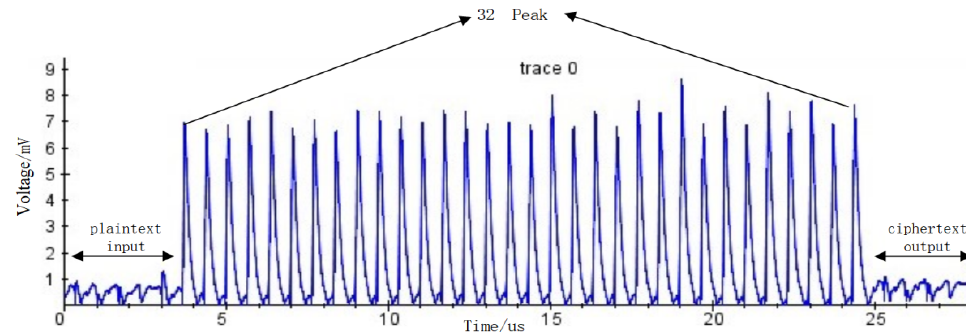
Figure 3. The power traces of SM4 encryption process.